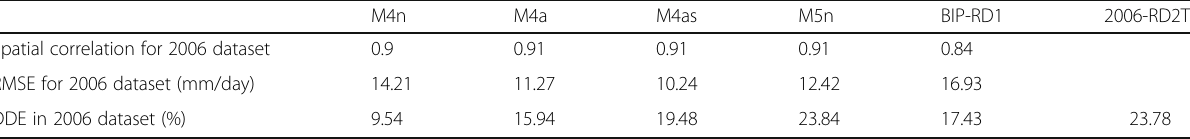
Table 8 The second stage testing results of ANN